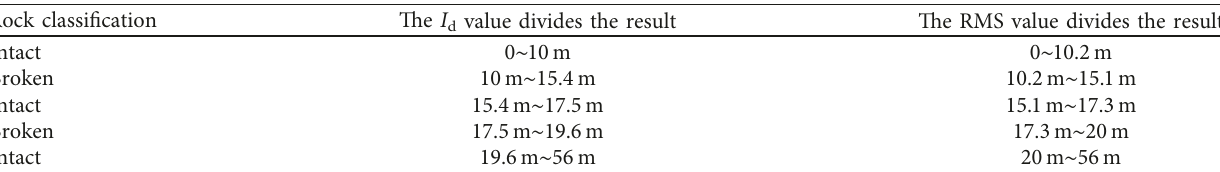
Table 6: Rock mass classification results of MWD and VMWD systems of in-seam borehole No. 22. Rock